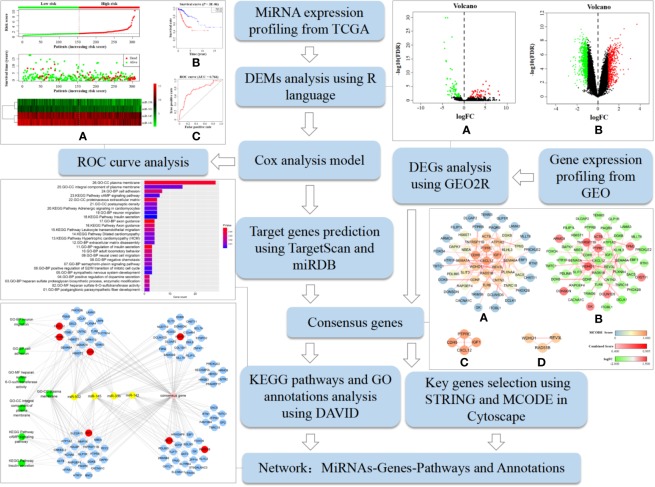
Analysis procedure of the data mining process used to screen tumor biomarkers and key genes in this study. It includes specific bioinformatics methods, data processing tools, and partial research results.